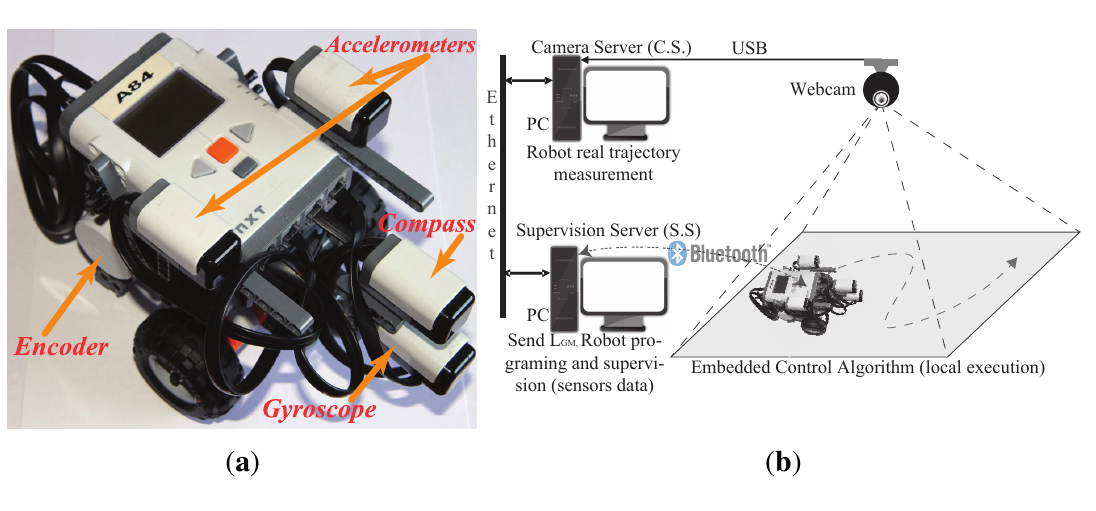
Differential LEGO NXT mobile robot with indoor zenithal camera